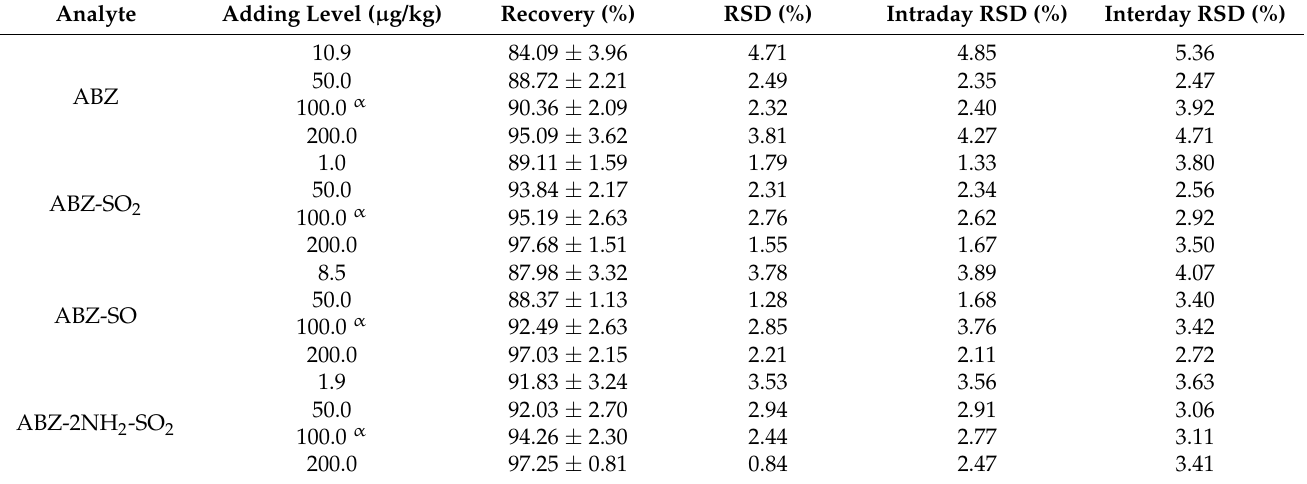
Table 6. Recovery and precision of ABZ, ABZ-SO 2 , ABZ-SO and ABZ-2NH 2 -SO 2 added to blank goose muscle (n = 6).